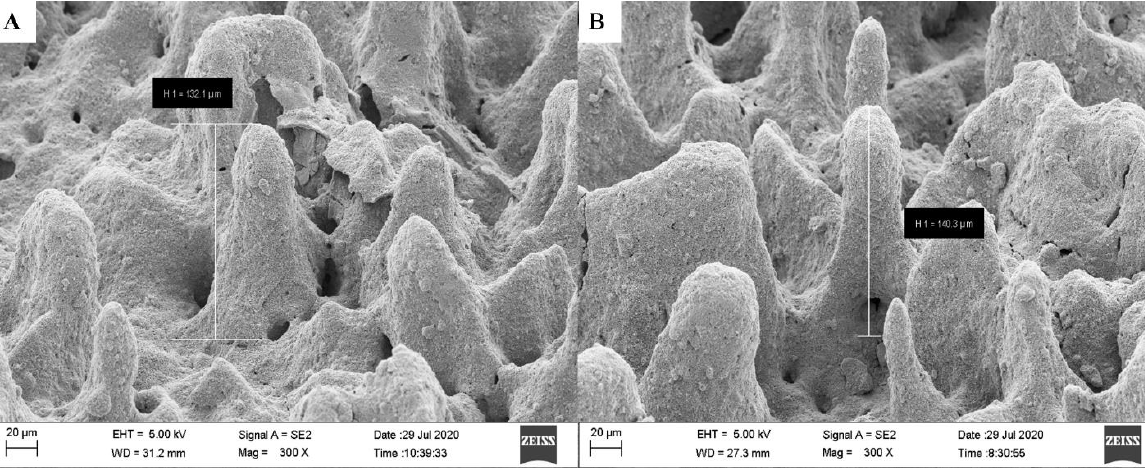
Figure 16. SEM micrographs of TiO 2 ’ s like-cluster structures with a height of ( A ) 132 ( B ) 140 µm distributed on its surface.